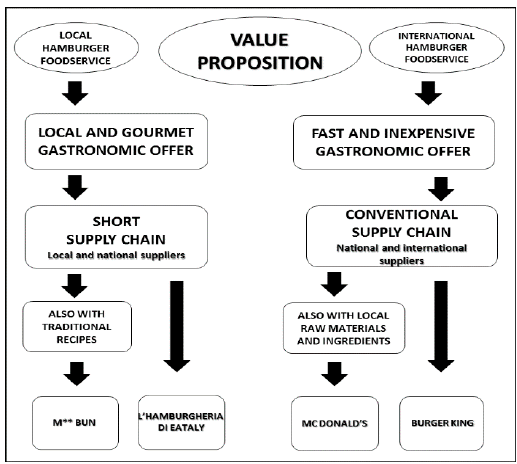
Figure 3. A flow-chart of the value propositions by the Hamburger Foodservice in the Greater Torino area.